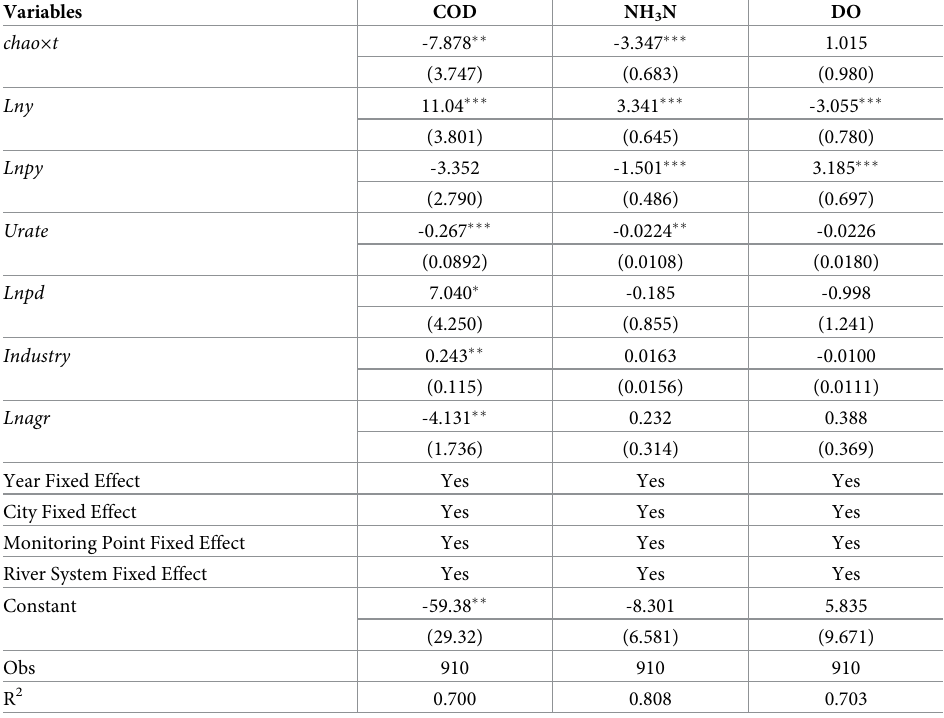
Table 7. DID method regression